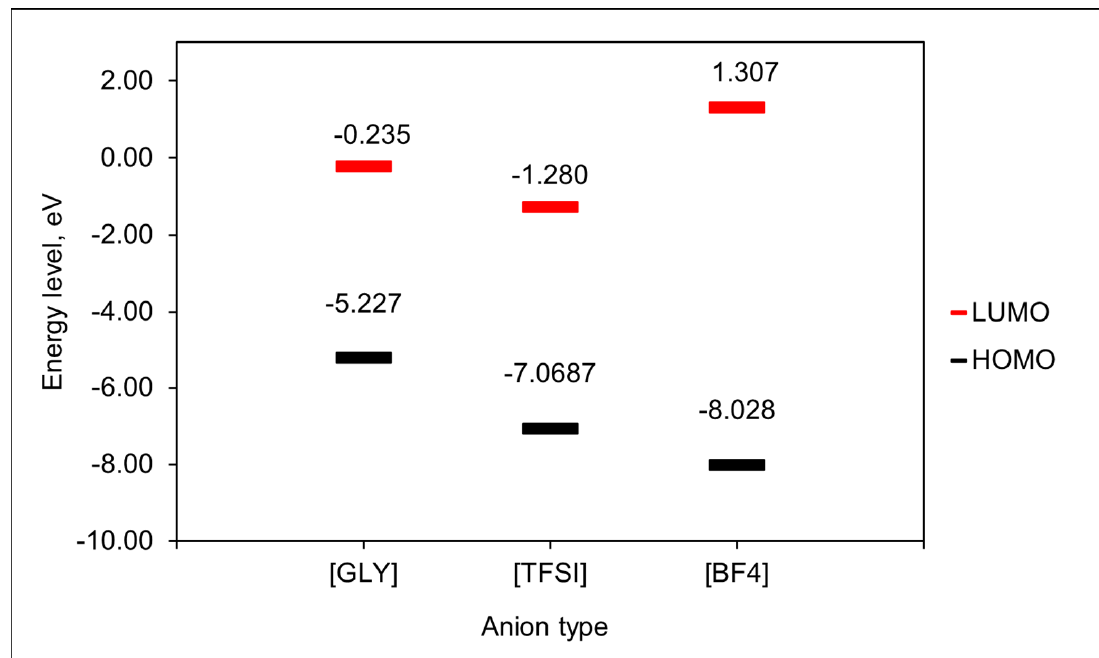
Figure 5. Values of HOMO-LUMO for [GLY], [BF 4 ], and [TFSI] anions.